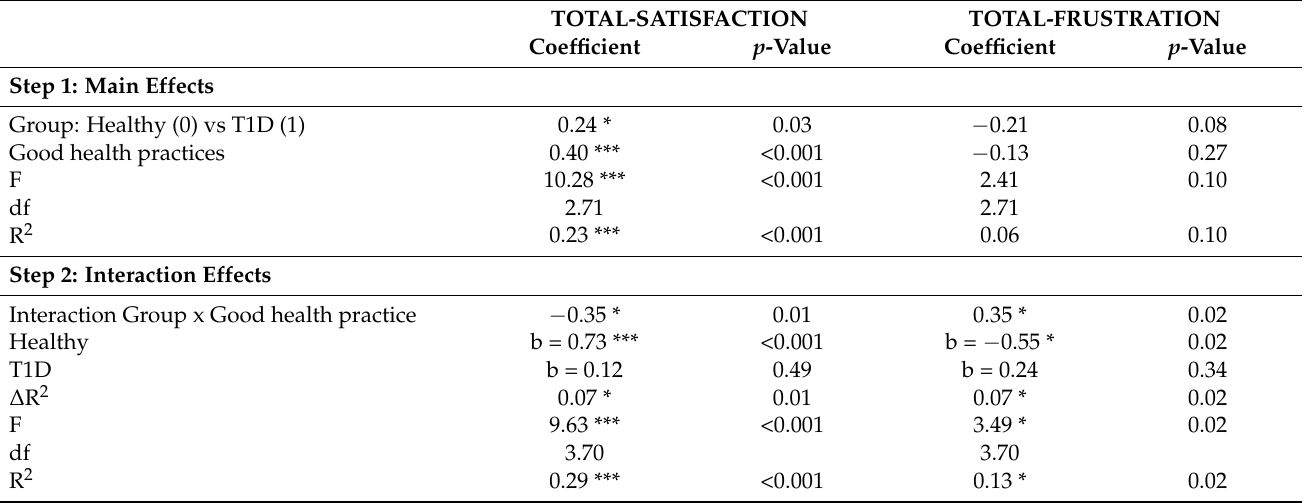
Table 3. Hierarchical regression for the mediating variables (Total Satisfaction and Total Frustration outcomes).